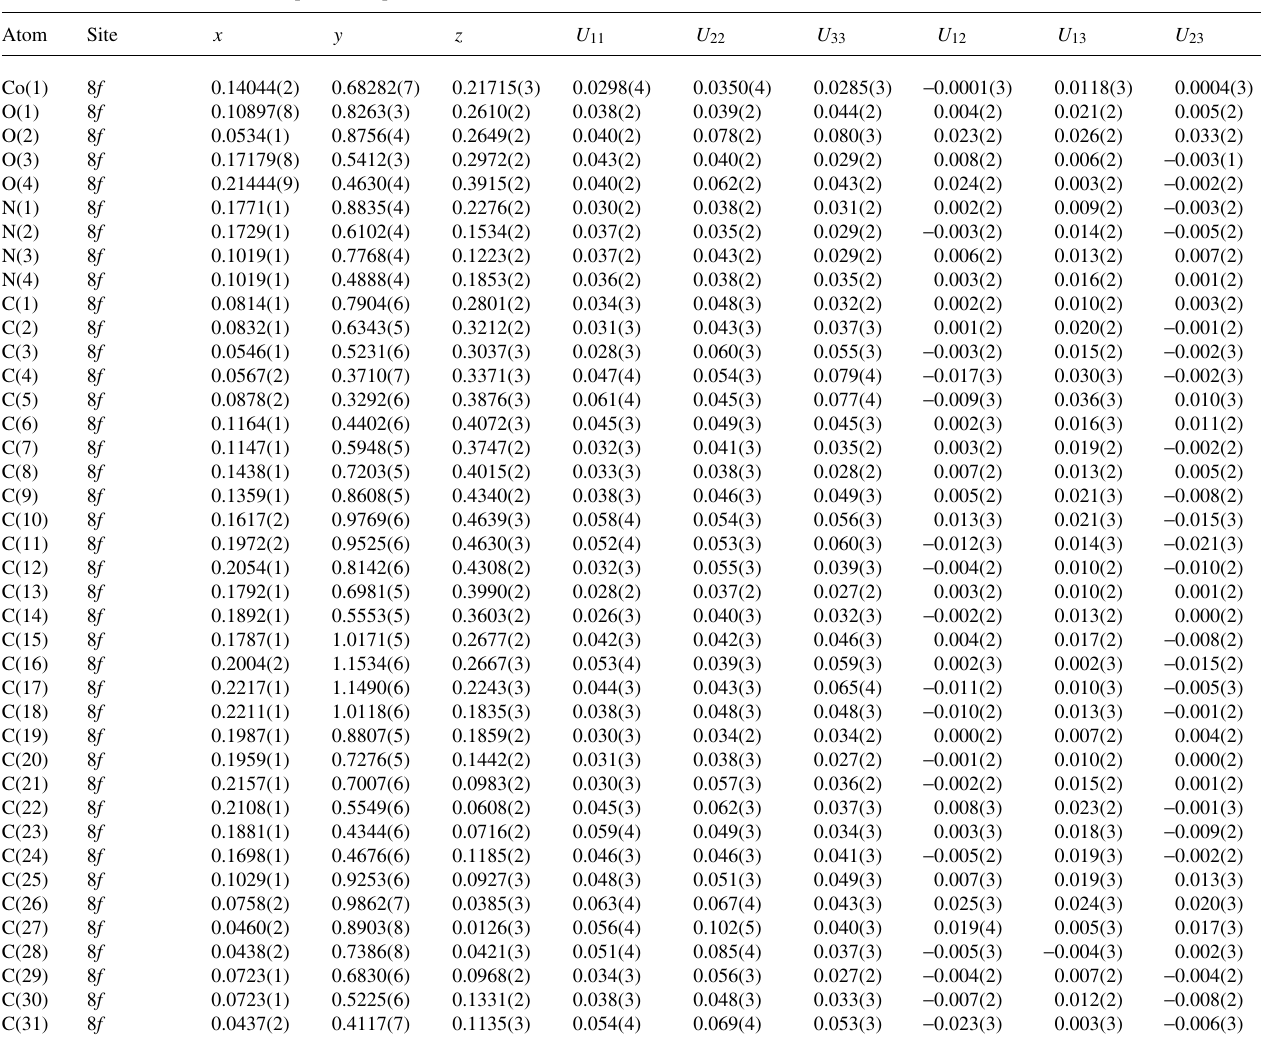
Table 3. Atomic coordinates and displacement parameters (in Å 2 ) .